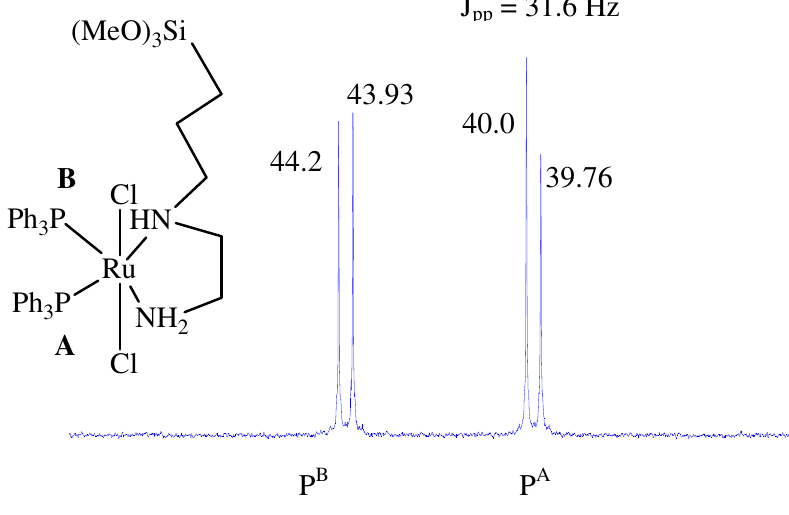
Figure 3. 31 P{ 1 H}-NMR spectroscopic data of complex 2 at δ coupling constant J = 31.6 pp